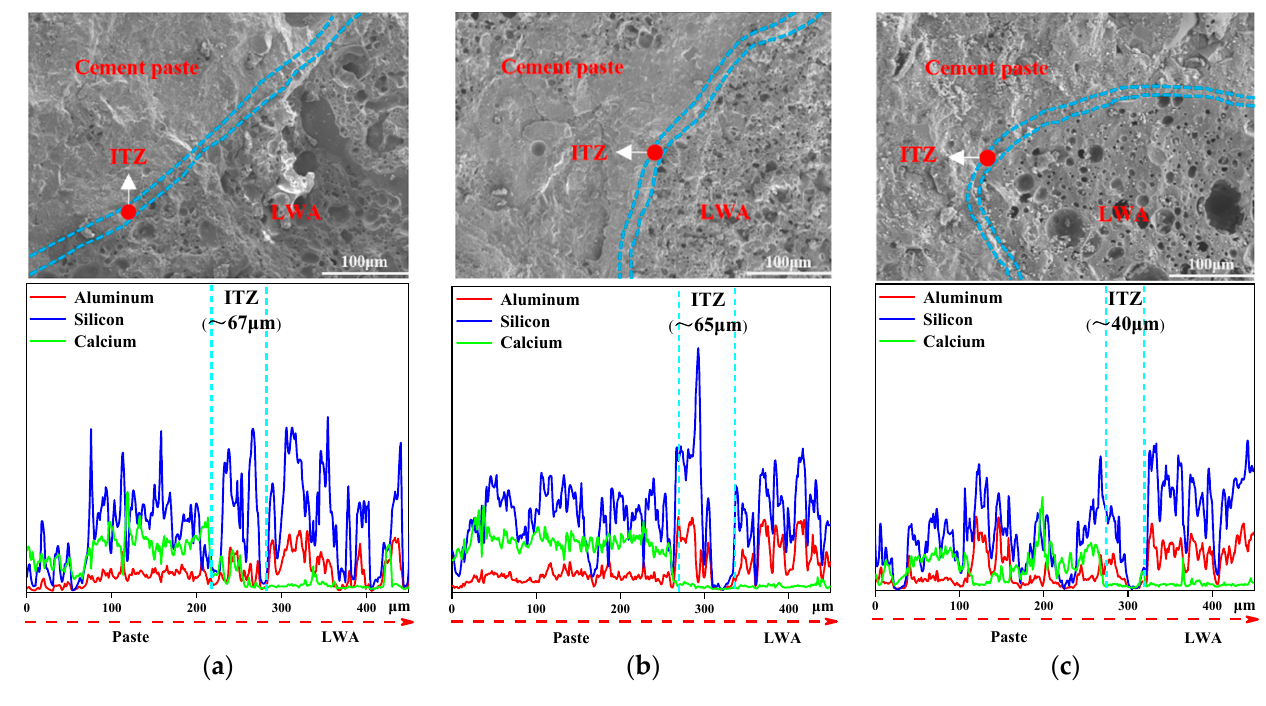
Figure 7. ITZ prepared by LWA with different particle sizes: ( a ) 0.15–4.75 mm; ( b ) 0.15–2.36 mm; ( c ) 0.15–1.18 mm.